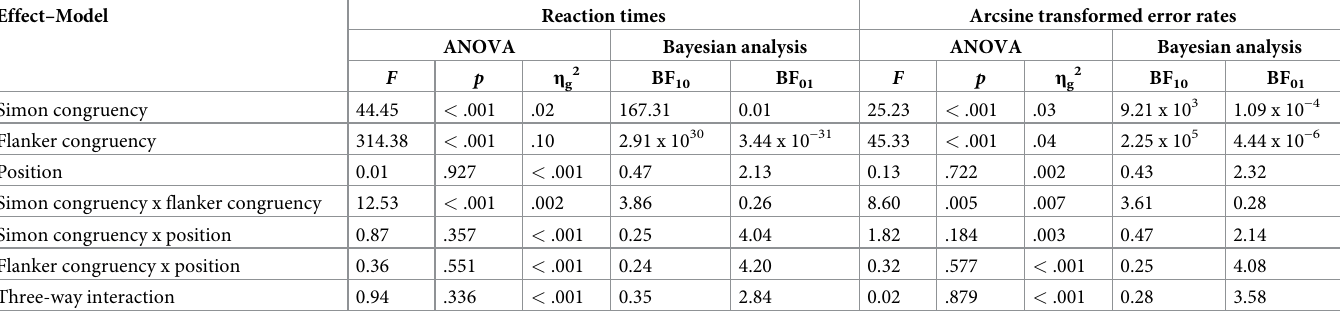
Table 4. Experiment 2: Inferential statistical values for the three-way analysis of variance (ANOVA) with Simon congruency (incongruent, congruent) and flanker congruency (incongruent, congruent) as within-subject variables, and position (simon horizontal–flanker vertical, Simon vertical–flanker horizontal) as a between- subjects variable, and Bayes Factors (BF) from model